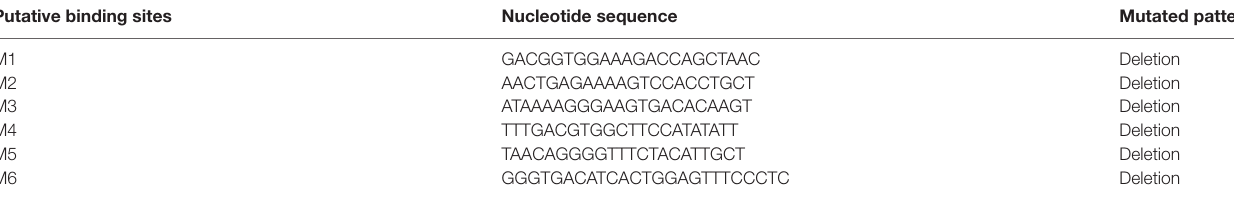
TABLE 2 | Primers used for site-directed mutations of putative binding sites on ToTNF α promoter. Putative binding